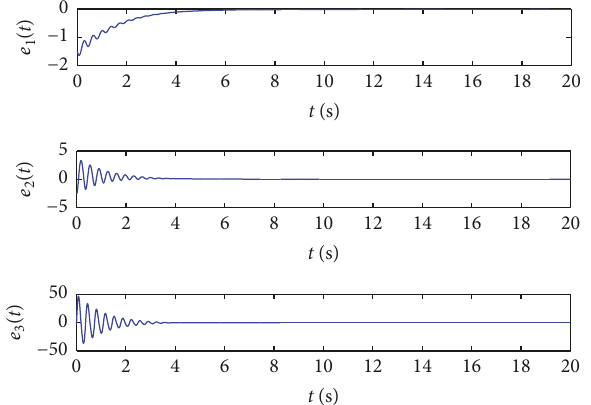
Figure 8: The controlled state trajectory of error system 𝑒(𝑡) .